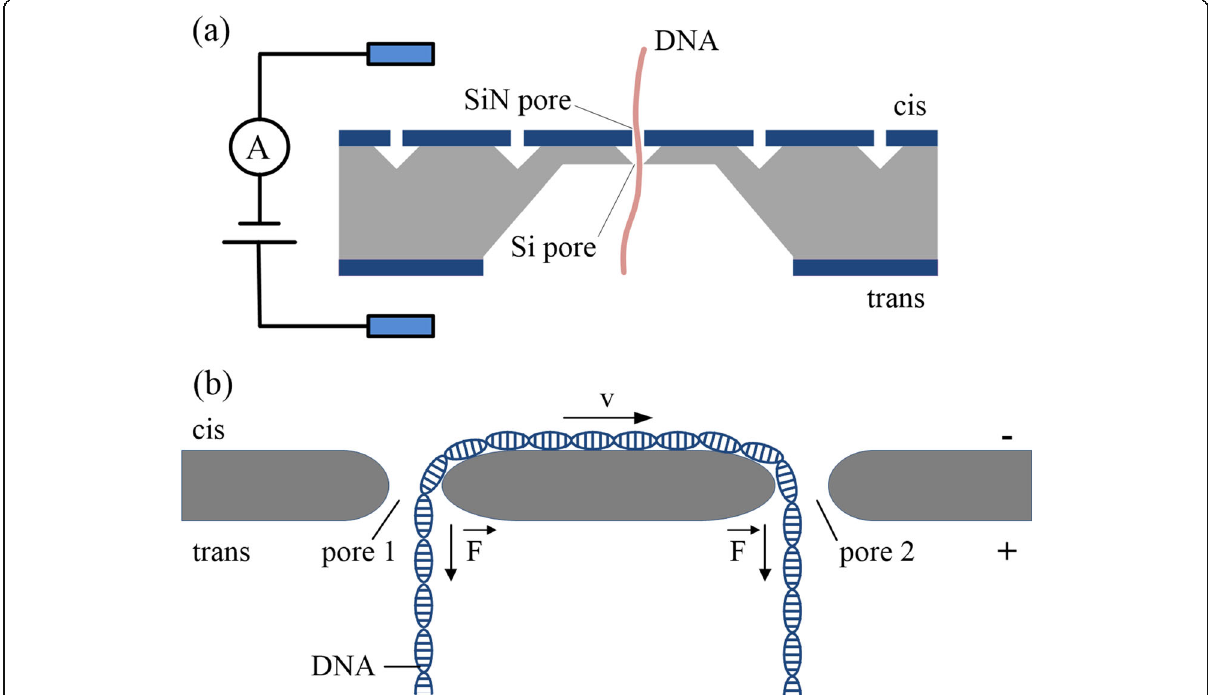
Fig. 2 a Schematic of two-layer nanopores system used for nanopore DNA detection [37]. b Schematic of double-nanopore system used for nanopore DNA detection